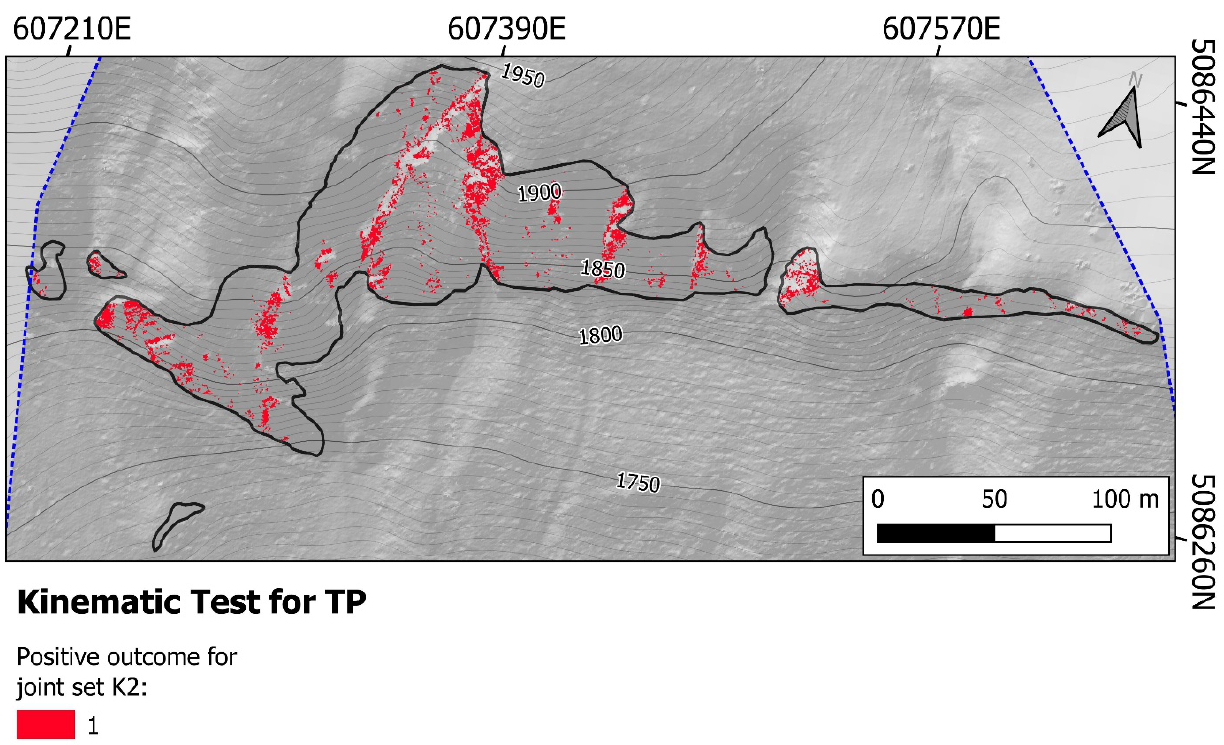
Figure A12. Image of the partial output file showing the kinematic test for TP performed considering only joint set K2.